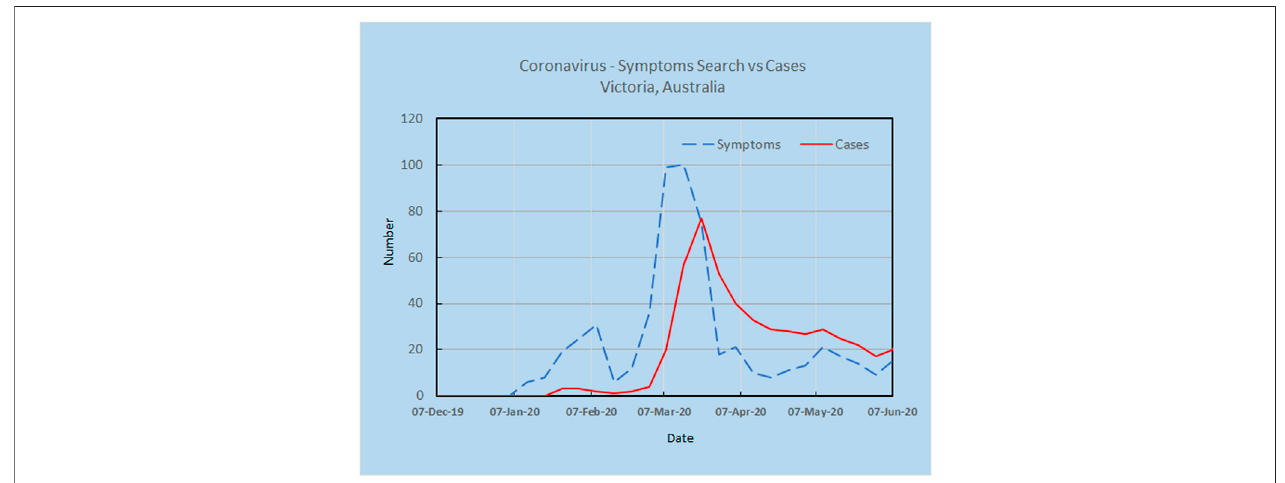
FIGURE 3 | Online search for symptoms reached a maximum during 8 – 15 March, while the peak for cases was 22 March, providing 1 – 2 weeks